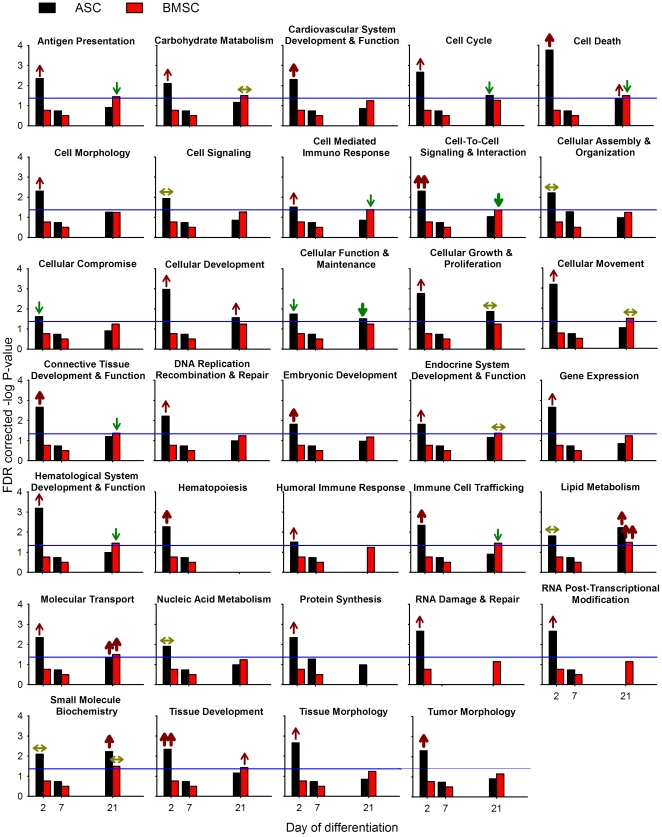
Functional analysis of differentially expressed genes between adipogenic and osteogenic differentiation in ASC and BMSC.Ingenuity Pathway Analysis® (IPA) of ASC (black bar) and BMSC (red bar) induced to differentiate towards the adipogenic and osteogenic lineages. The blue line denotes an FDR of 0.05. The arrows present at the top of each bar denote the overall effect on the function inferred by the gene annotation using IPA ( = highly activated in adipogenic vs. osteogenic differentiation;  = activated in adipogenic vs. osteogenic differentiation; ↑ = tends to be activated in adipogenic vs. osteogenic differentiation;  = highly activated in osteogenic vs. adipogenic differentiation;  = activated in osteogenic vs. adipogenic differentiation; ↓ = tends to be activated in osteogenic vs. adipogenic differentiation; ↔ = not apparent overall activation or inhibition).